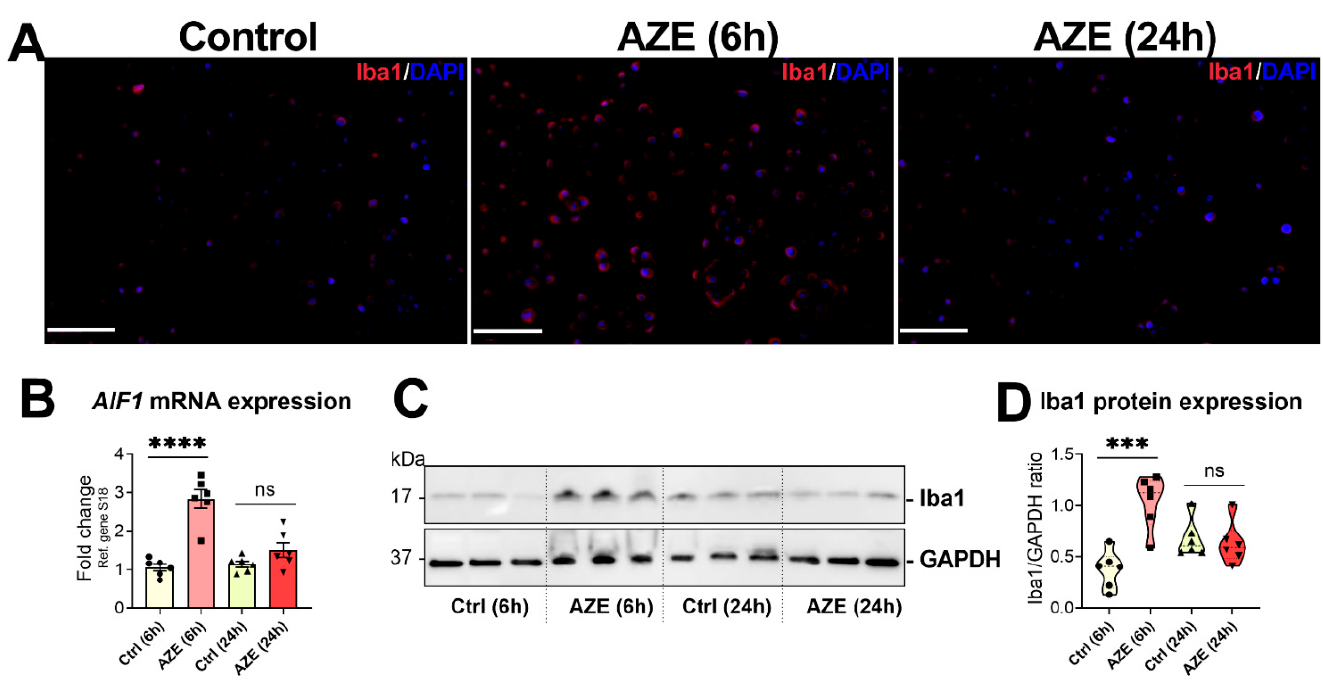
Figure 5. AZE treatment induces AIF1 /Iba1 expression in BV2 cells. ( A ) Representative photomicrographs of Iba1+ staining in the BV2 microglial cell line. Cells were either left untreated or treated with AZE as indicated and then processed for immunocytochemistry (ICC) as detailed in Section 2. Red = Iba1+ cells (Alexa Fluor 594). DAPI = nuclei. Scale bar = 50 µm. ( B ) AIF1 gene expression, as determined by real-time qPCR. Fold changes were calculated using the Δ Ct method, with baseline expression set to 1. Data is the mean ± SEM (n = 6). **** p < 0.0001 vs. Ctrl at the indicated time points. ( C , D ) Western blot analyses of Iba protein expression and densitometric analyses of blots. Data reported is the mean ± SEM, from two independent experiments using separate batches of cells (n = 6). GAPDH was used as loading control. Ns = not significant. *** p < 0.001 or **** p < 0.0001 vs. Ctrl at the indicated time, as determined by ANOVA followed by Sidak’s post hoc test.